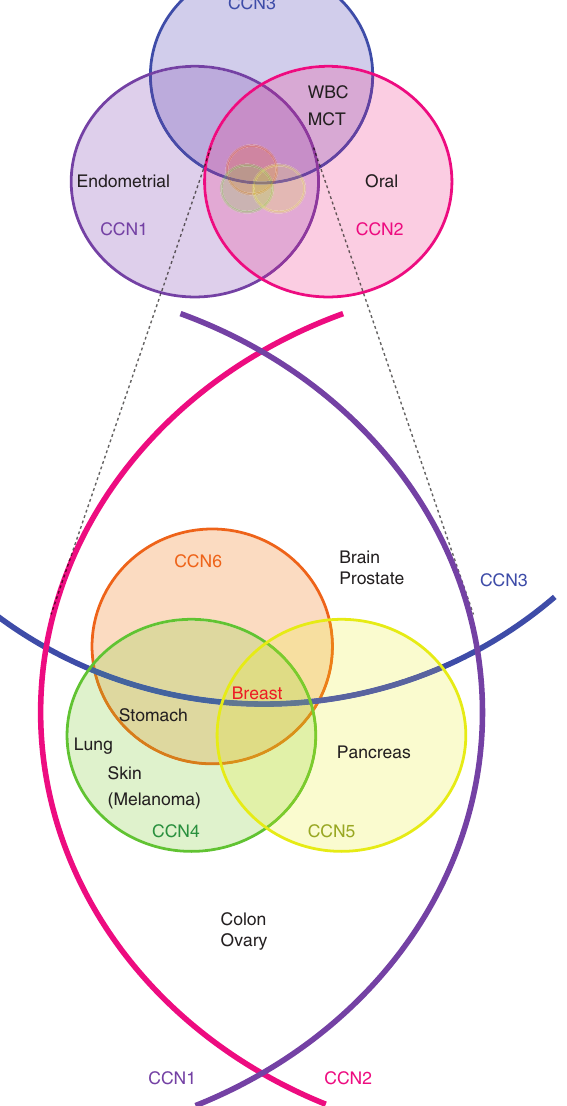
Figure 5 Comprehensive illustration of the organ-wise tumor-CCN family